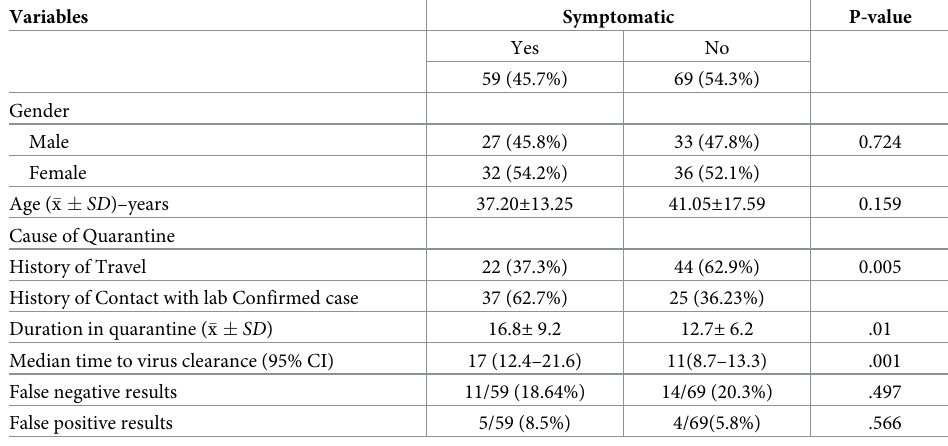
Results are expressed as mean ± standard deviation, and number